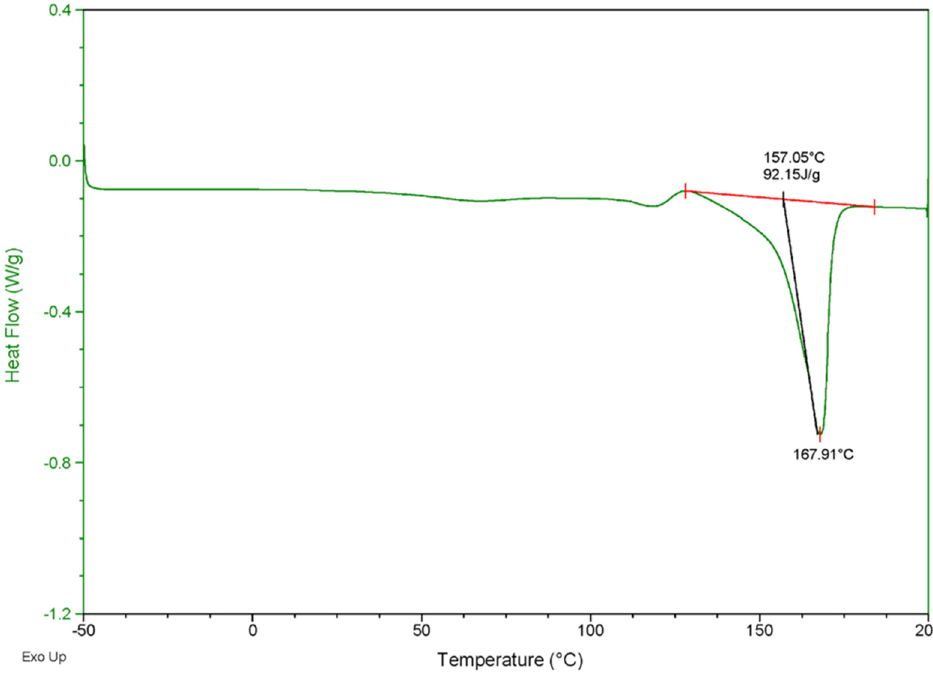
Figure 7. DSC thermogram of PHB biosynthesized by Priestia sp. strain JY310.